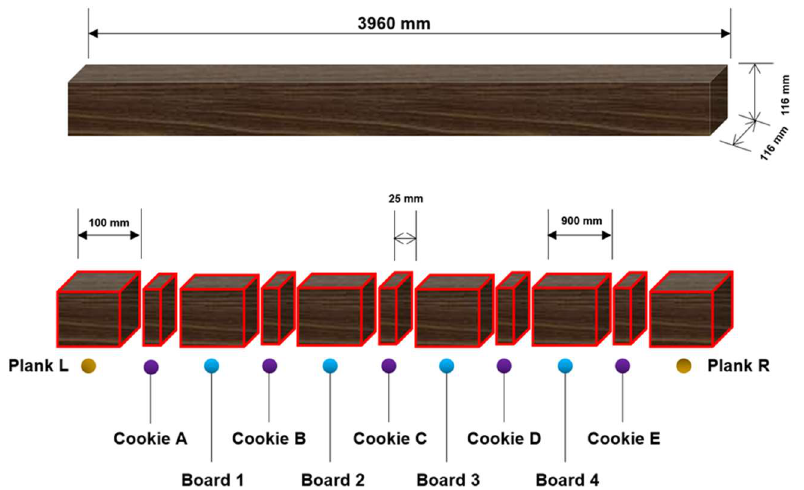
Figure 1. Cutting pattern of the baby-square western hemlock.